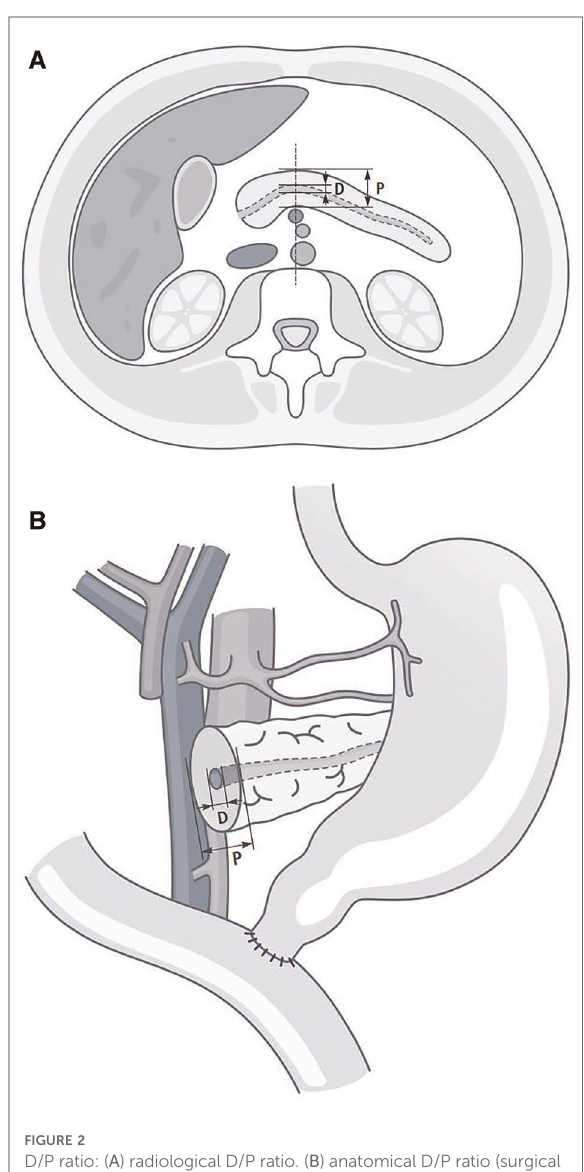
FIGURE 2 D/P ratio: ( A ) radiological D/P ratio. ( B ) anatomical D/P ratio (surgical